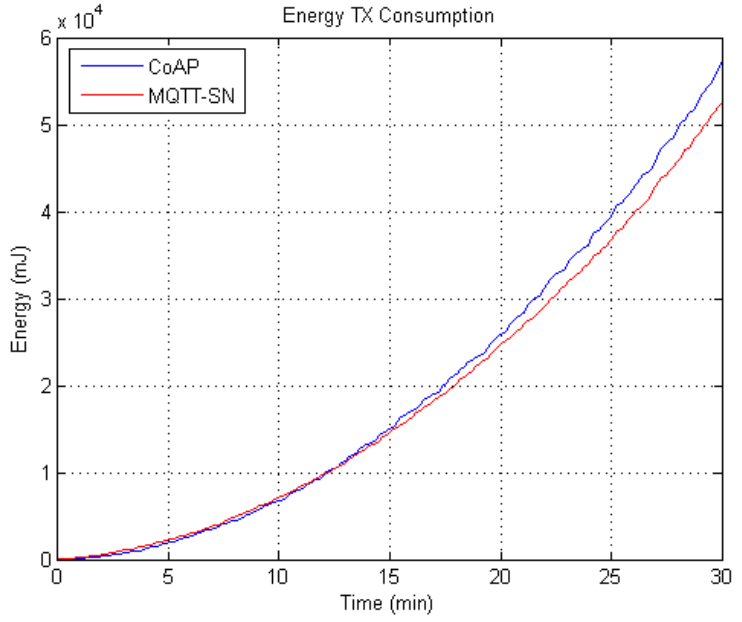
Figure 9. Energy Consumption comparison between CoAP and